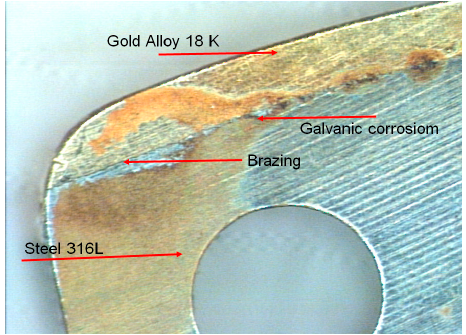
Figure 22. Galvanic corrosion in a gold-steel assembly.